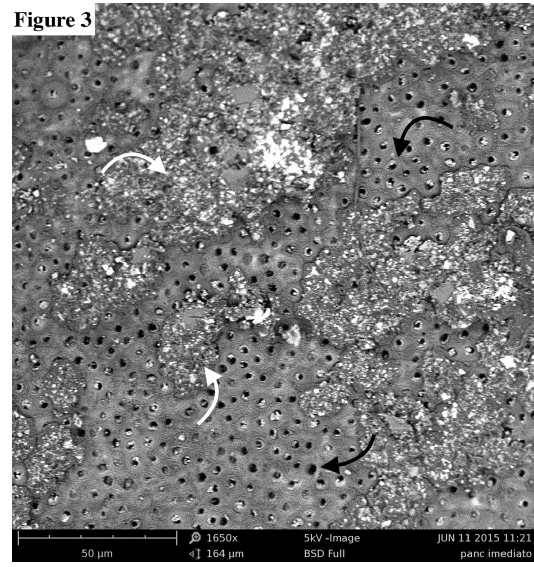
Figure 1 – (Magnification: 3900x – Scale bar: 20µm) - Representative SEM image of fractured specimen from AllCem group (dentin side). Note open tubules with resin tag of Ambar adhesive. Black arrow: dentin tubule open.